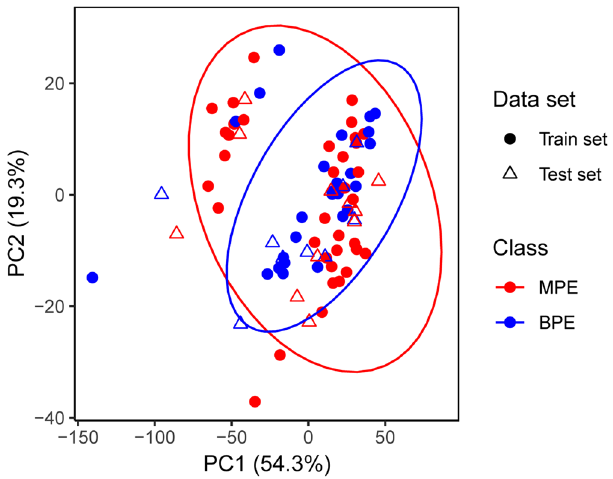
Figure 2. Scatter plots of the first two principal components (PCs). The variance explained PC1 and PC2 were 54.3% and 19.3%, respectively. 82 cases were randomly split into train set (n = 62, filled circle) and test set (n = 20, hollow triangle). 47 MPE cases are colored red, and 35 BPE cases are colored blue.